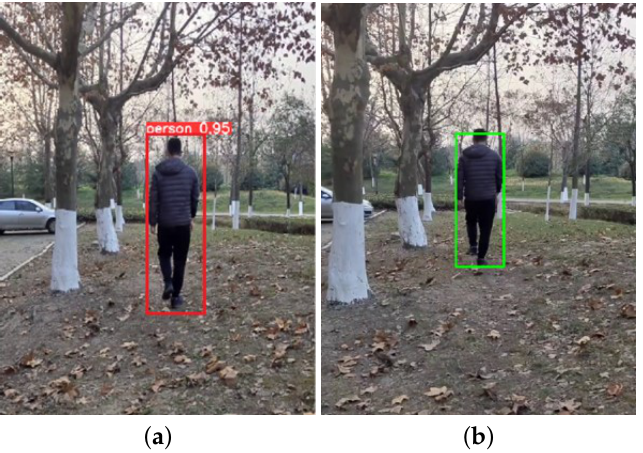
Figure 3. Comparison of detection and tracking results. ( a ) the result of the detection. ( b ) the result of